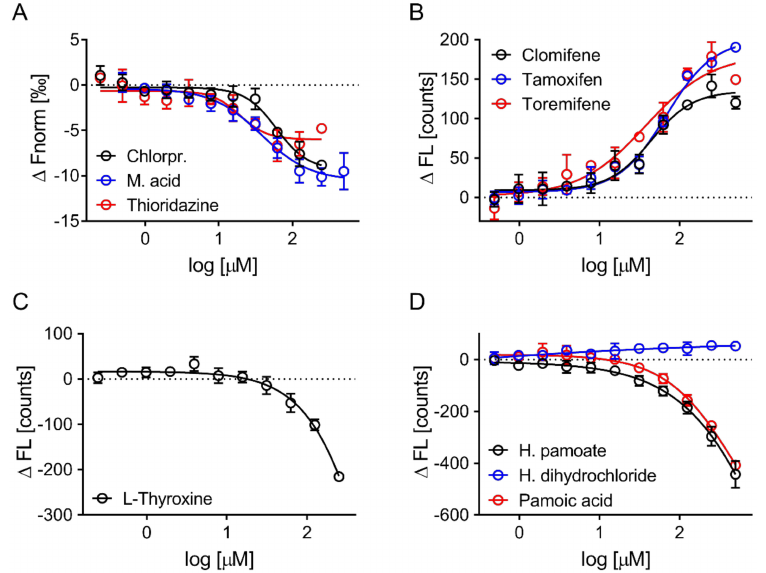
Figure 6. Hit confirmation by microscale thermophoresis. Hits were tested by concentration response from 500 or 250 µ M. ( A ) Three out of these eight hits altered thermophoresis without affecting the initial fluorescence (chlorpromazine, meclofenamic acid, thioridazine), ( B ) three increased initial fluorescence (clomifene, tamoxifen, toremifene), and ( C , D ) two reduced initial fluorescence ( L -thyroxine, hydroxyzine pamoate) in a concentration-dependent fashion. ( D ) Pamoic acid reduced initial fluorescence in a concentration-dependent fashion. Data are expressed as the mean ± SD of three independent